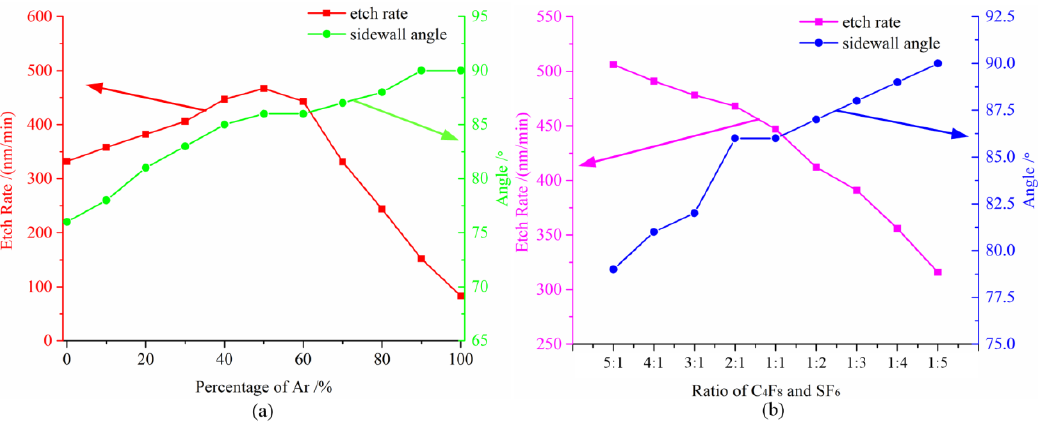
Figure 2. ( a ) The test results of the etching rate and sidewall angle versus the Ar percentage; ( b ) the test results of the etching rate and sidewall angle versus the ratio of C 4 F 8 and SF 6 .